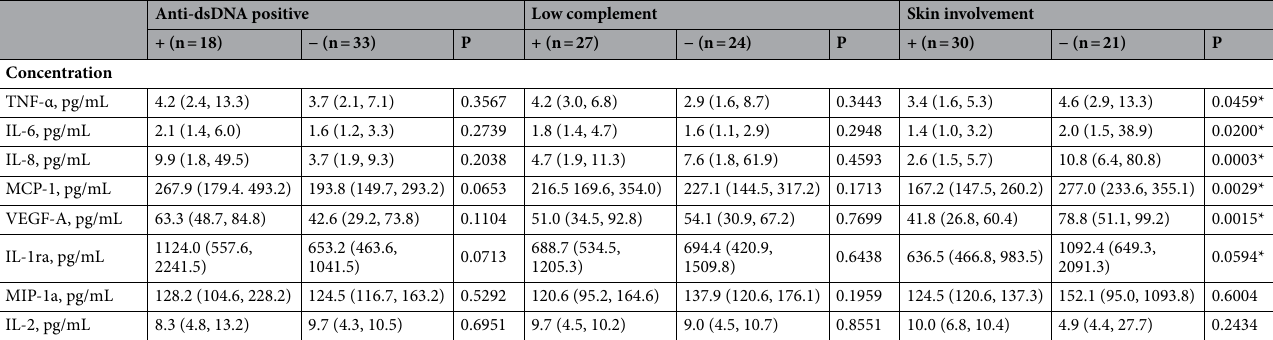
Table 2. Association between clinical parameters and proinflammatory cytokines at baseline. Median (25% quantile, 75% quantile). *p < 0.05, Wilcoxon rank sum test.